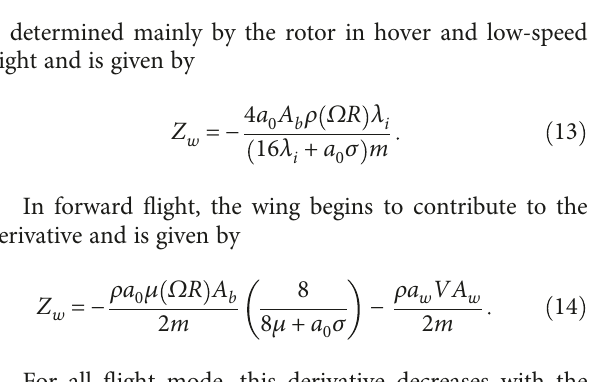
Figure 11: Variation of the derivative M